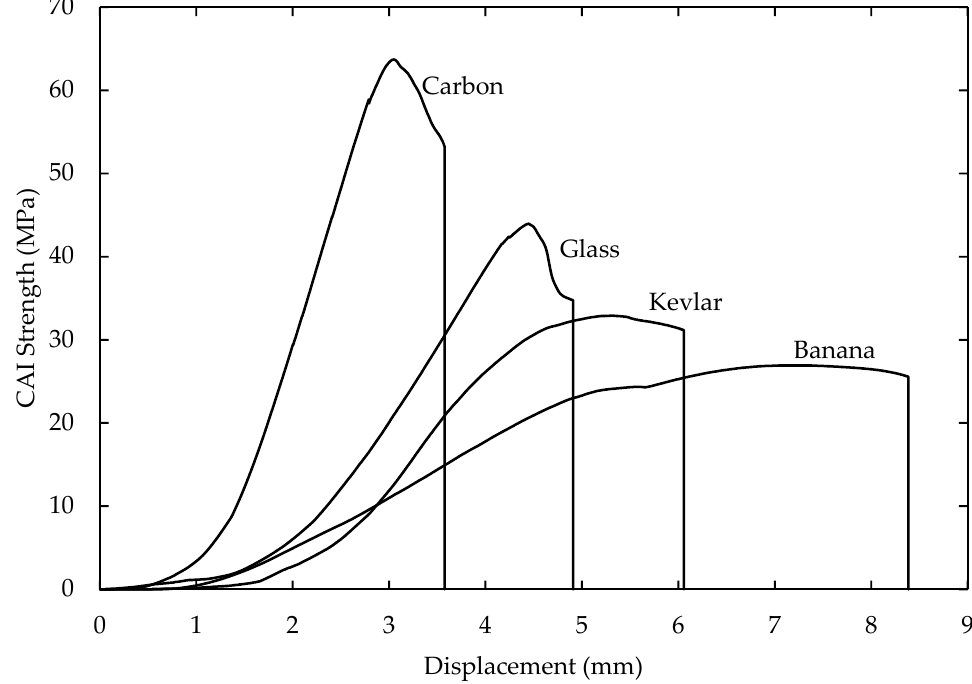
Figure 11. The variation of compression after impact (CAI) strength with the displacement for four different sandwich structures subjected to an energy impact of 10 J.